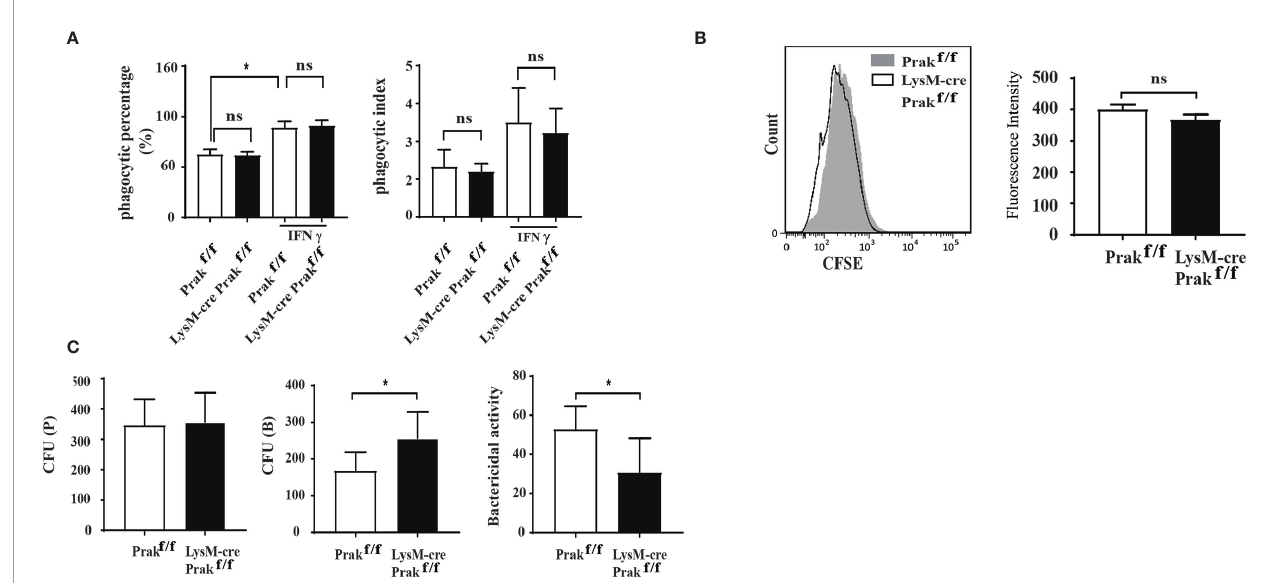
FIGURE 3 | The phagocytic and bactericidal activities of Prak -de fi cient macrophages. (A) Peritoneal macrophages were cultured in the presence or absence of IFN- g (200U/ml) for 24 h and then mixed with 100 m l fl uorescent microspheres for 1h. Phagocytosis of the microspheres was detected by fl ow cytometry. The results were converted into phagocytic percentage and phagocytic index. The experiments were repeated three times. Data are presented as mean ± SD. ns, not signi fi cant. (B) Peritoneal macrophages from Prak- de fi cient (n=5) and wild type (n=3) mice were incubated for 1 h with CFSE-labeled L. monocytogenes and analyzed by fl ow analysis. Representative histograms from 3-5 independent experiments are shown on the left and the mean fl uorescence Intensity is presented as mean ± SD on the right. ns, not statistical. (C) The macrophage was incubated with L. monocytogenes for 1 h. The number of bacteria inside the macrophage was determined immediately after washing with PBS [CFU (P)] or after further incubation for 4 h in the presence of 50 µg/ml gentamicin [CFU (B) ]. The bactericidal activity was calculated as follows: [1-CFU (B)/CFU (P]×100 (%). Data from three independent experiments are presented as mean ± SD. * P < 0.05 by t -test. ns, not signi fi